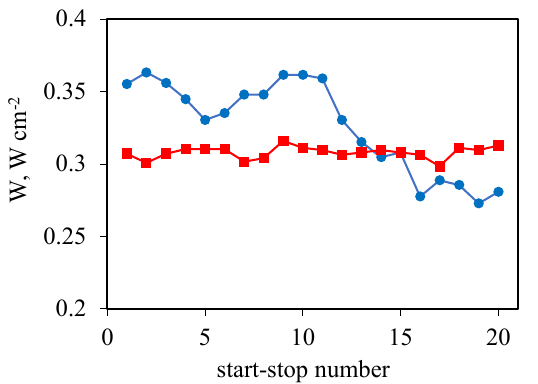
Figure 5. Power density values at 0.8 A cm − 2 vs. the number of passed start–stop cycles for two MEAs with different cathodes: the Celtec®P1000 cathode (circles) and CNF cathode (squares). In addition, in order to show the performance stability, the obtained data were pre- sented as a graph of the ratio N between the voltage after a given start–stop and the voltage after the first start–stop vs. the number of passed start–stop cycles. The data were taken from the I–V curves at 0.8 A cm 2 (Figure 6).